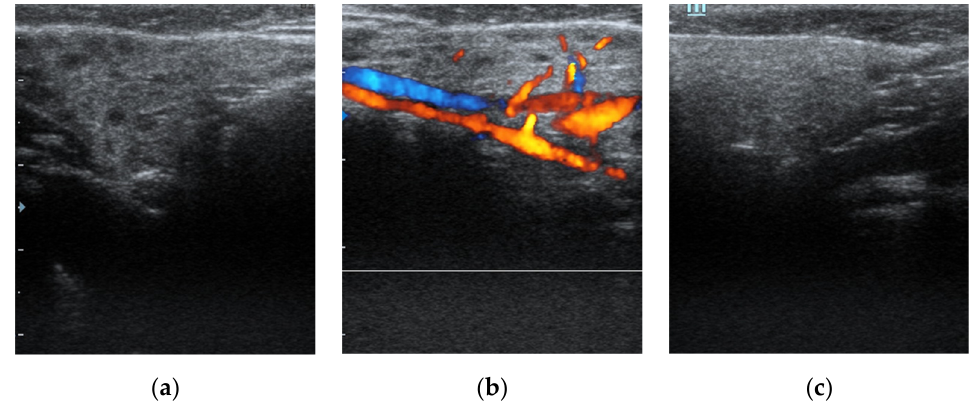
Figure 1. Ultrasound diagnostics of juvenile recurrent parotitis. ( a ) displays a unilaterally affected parotid gland on the right side of a patient. Note heterogeneous parenchyma with several hypoechoic nodules indicating duct dilatation. ( b ) demonstrates increased blood flow of the same parotid gland with Doppler mode. In ( c ), a normal parotid gland on the left side of the same infant is shown as a comparison.